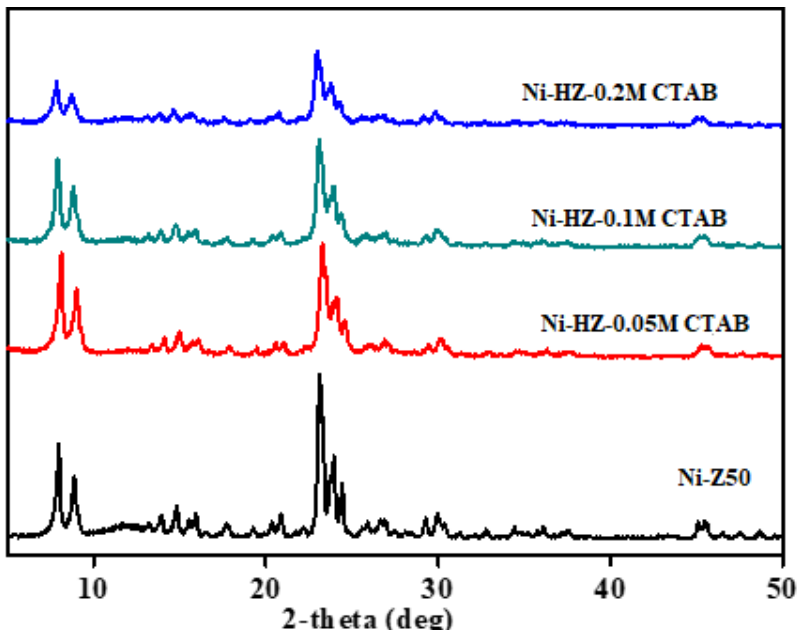
Figure 2. XRD patterns of nickel-supported desilicated zeolite samples Ni- Z50, Ni-HZ-0.05 M CTAB, Ni-HZ-0.1 M CTAB, and Ni-HZ-0.2 M CTAB. The desilication of ZSM-5 was carried out using a fixed amount of NaOH (0.5 M) at different concentration amounts of surfactant (e.g., hexadecyltrimethylammonium bromide). Whereas, 0.05M, 0.1M and 0.2M showed CTAB surfactant concentrations which was used in desilication reassembly process.